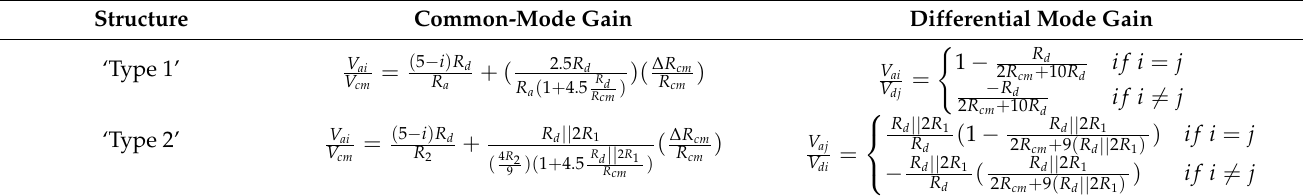
Table 4. Common-mode and differential gain for mismatched common-mode impedances (only R cm s not